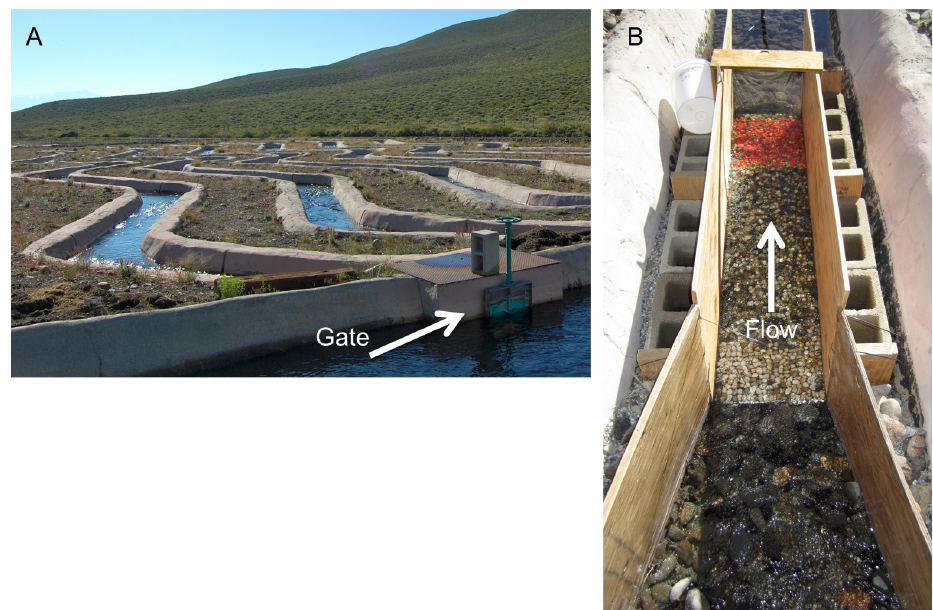
Fig 1. (A) The stream channels used in the experiment at the Sierra Nevada Aquatic Research Laboratory (SNARL), Mammoth Lakes, CA. Each of the four meandering channels is 50 m long by 1 m wide, and flow is controlled by a head gate (bottom right corner of the image for the first channel). (B) Plywood flumes used in the experiment. Sediments were glued to the plywood bottoms extending 1 m upstream from an experimental patch of moveable sediments (colored orange) where caddisflies built silk